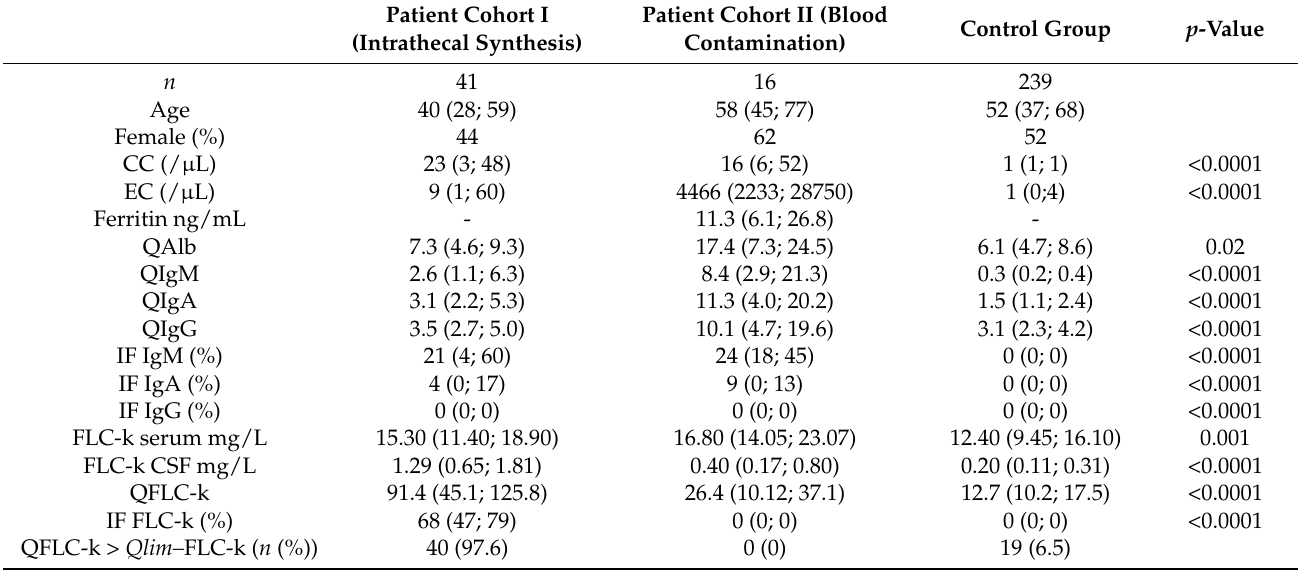
Table 1. Baseline characteristics and cerebrospinal fluid